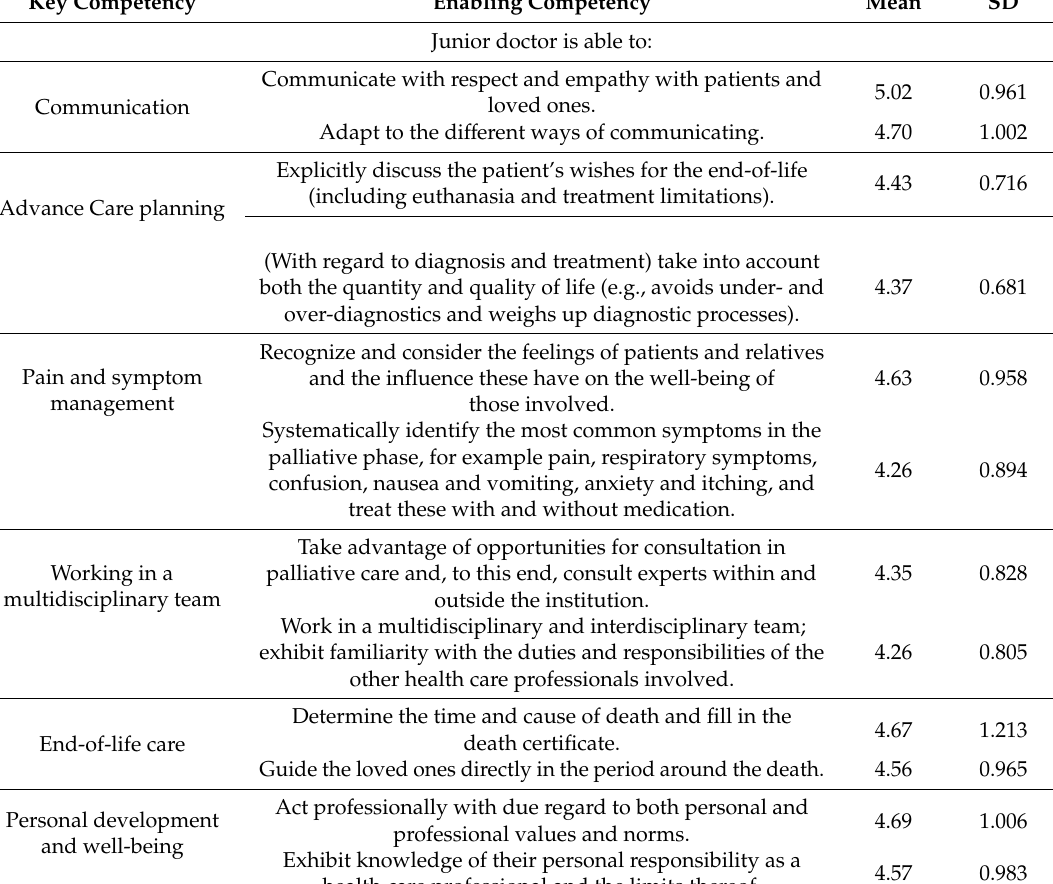
Table 3. Panel members’ highest mean ratings of the enabling competencies in palliative care and their standard deviations per key competency ( N panel members = 54) (1–6